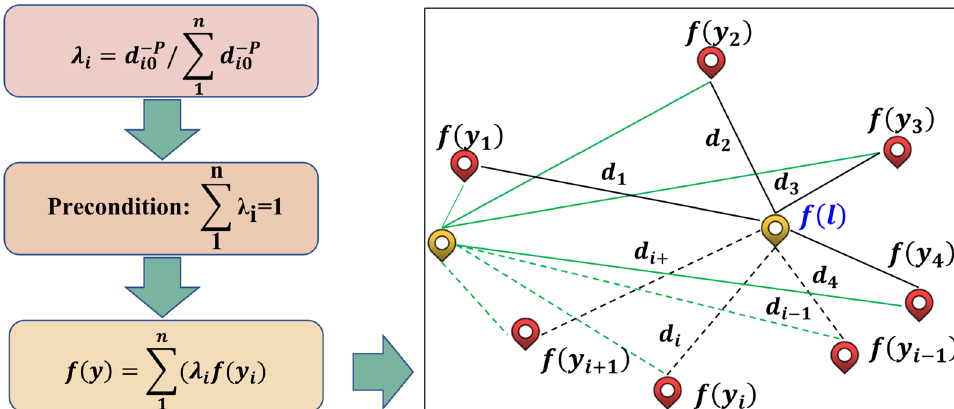
Fig. 8 Inverse distance weighted interpolation theory (modified from Nian et al. 2019)